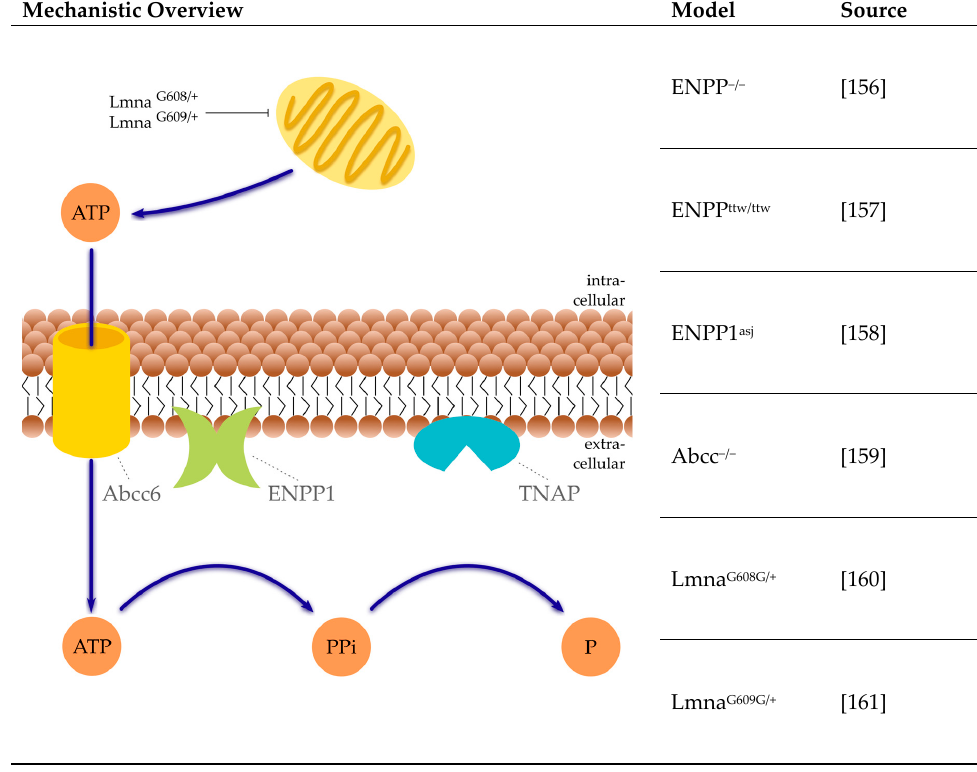
Figure 3. Selected mice models of reduced serum pyrophosphate concentration and their mechanisms. Blue arrows: pathway. References: [156–161]. Abcc: adenosinte